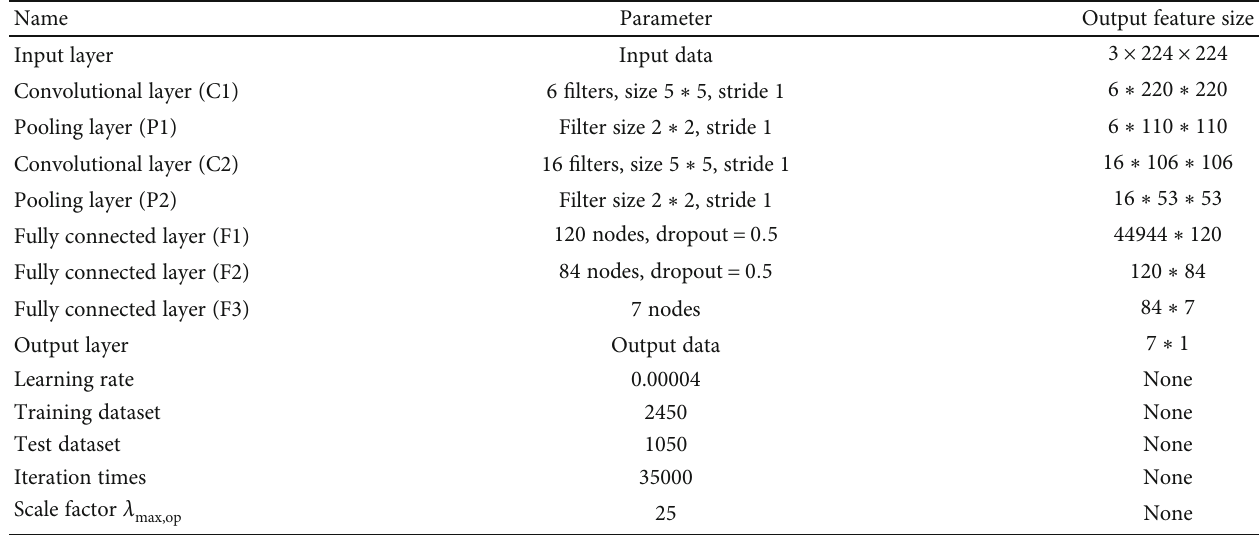
Table 3: Network